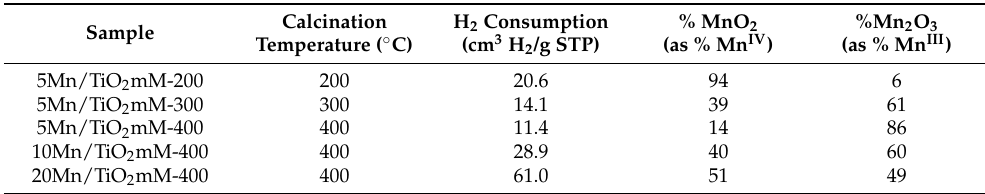
Table 2. Relative amount in percent of MnO 2 and Mn 2 O 3 in the Mn/TiO 2 mM samples calcined at various temperatures.